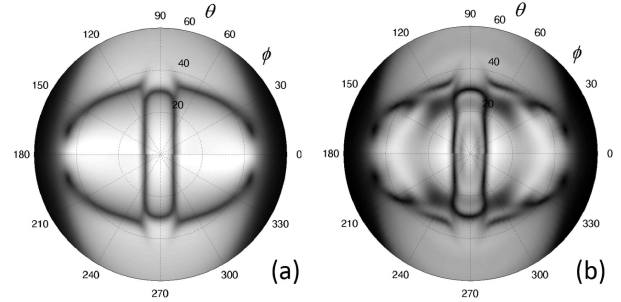
Figure 6. Experimental recordings of a [0 ˝ ] 8 C/E laminate: P-UPS at f c = 5 MHz ( a ) and harmonic ultrasonic polar scan (H-UPS) at f = 5 MHz ( b ).